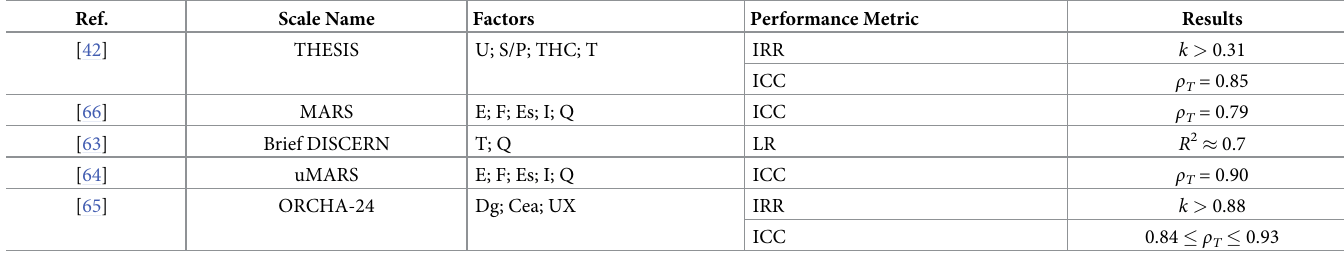
Table 1. Various mHealth app rating scale.